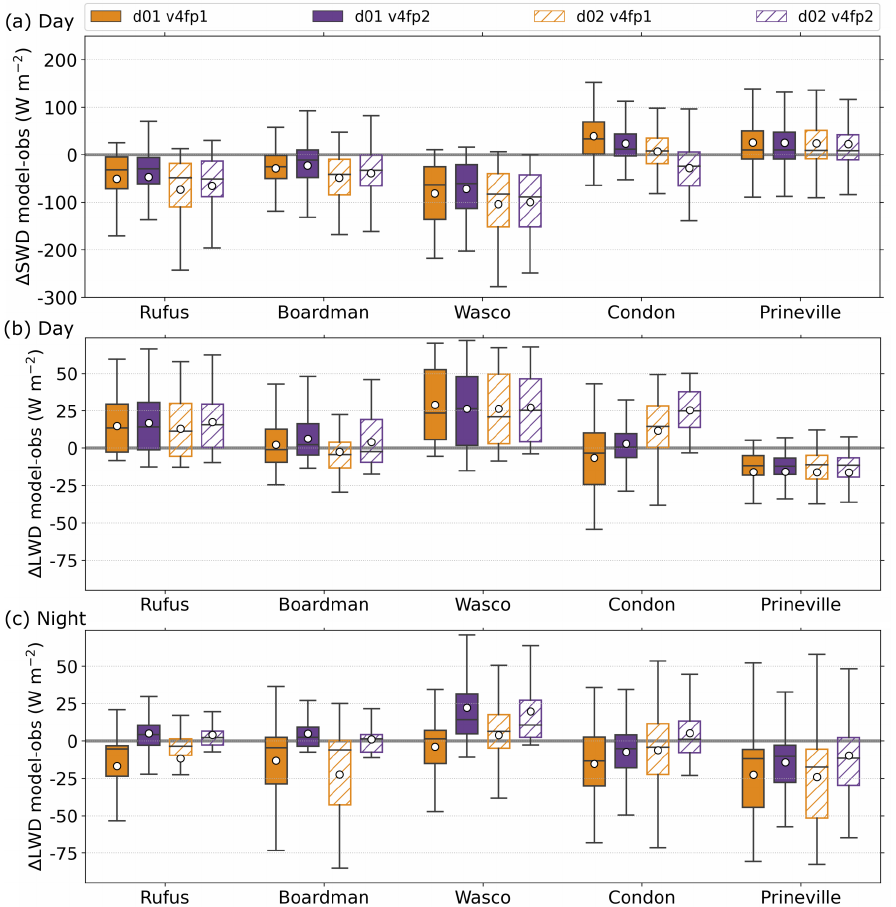
Figure 12. Box plot of (a) daytime surface shortwave downward radiation flux bias ( (cid:49) SWD) as well as (b) daytime and (c) nighttime surface longwave downward radiation flux bias ( (cid:49) LWD) between different model runs (versions: v4fp1, v4fp2; domains: d01, d02) and the observations at Rufus, Boardman, Wasco, Condon, and Prineville during the CAP period. The white circles indicate the mean biases, boxes show the interquartile range with the median indicated by the horizontal line, and the whiskers extend to the points that lie within 1.5 times the interquartile range of the lower and upper